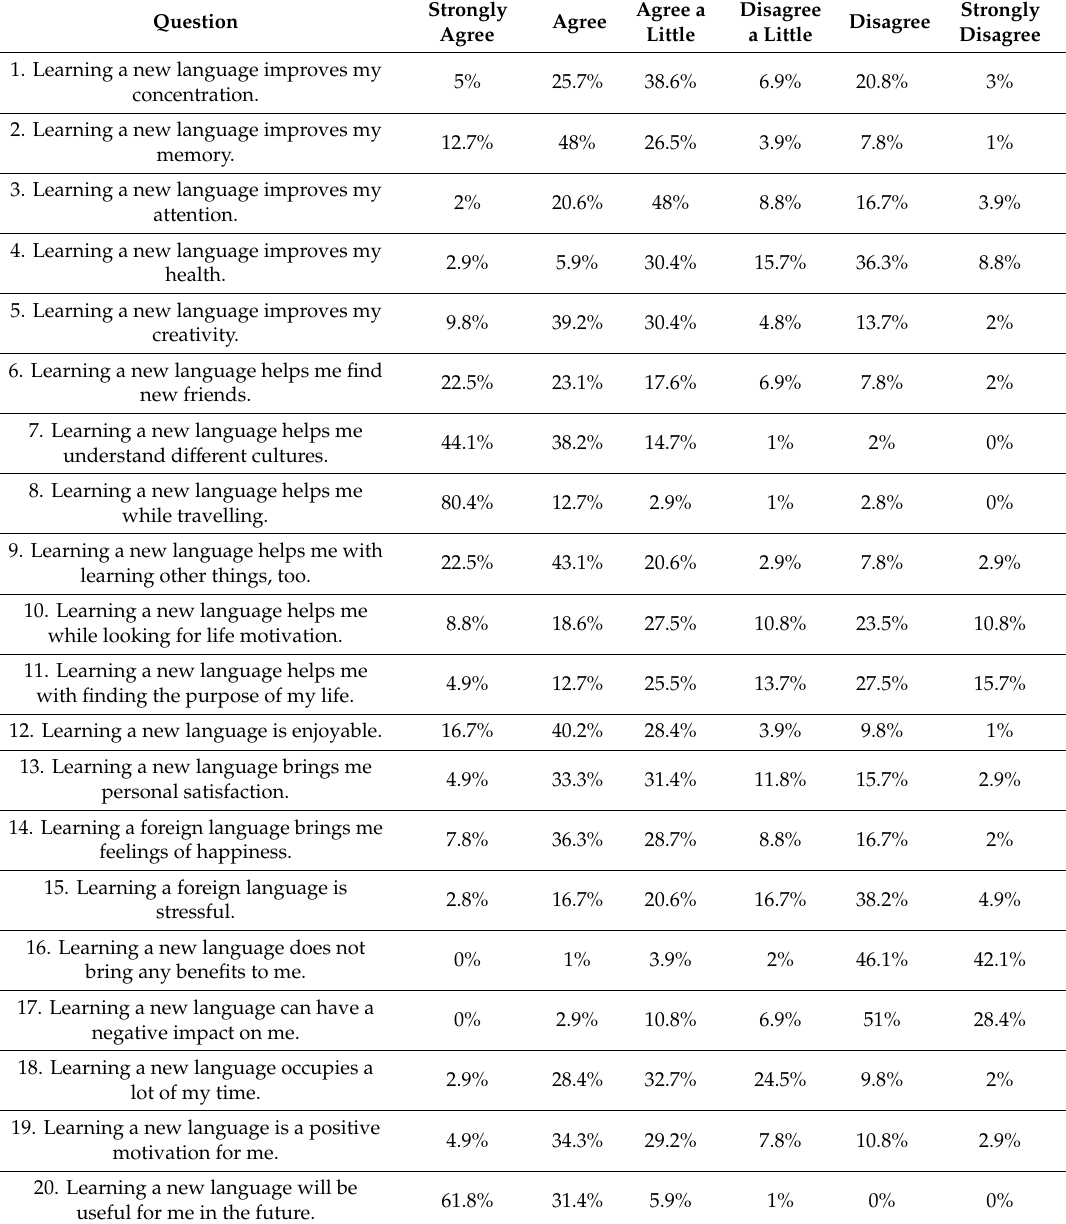
Table 2. An overview of the questionnaire results of the young control